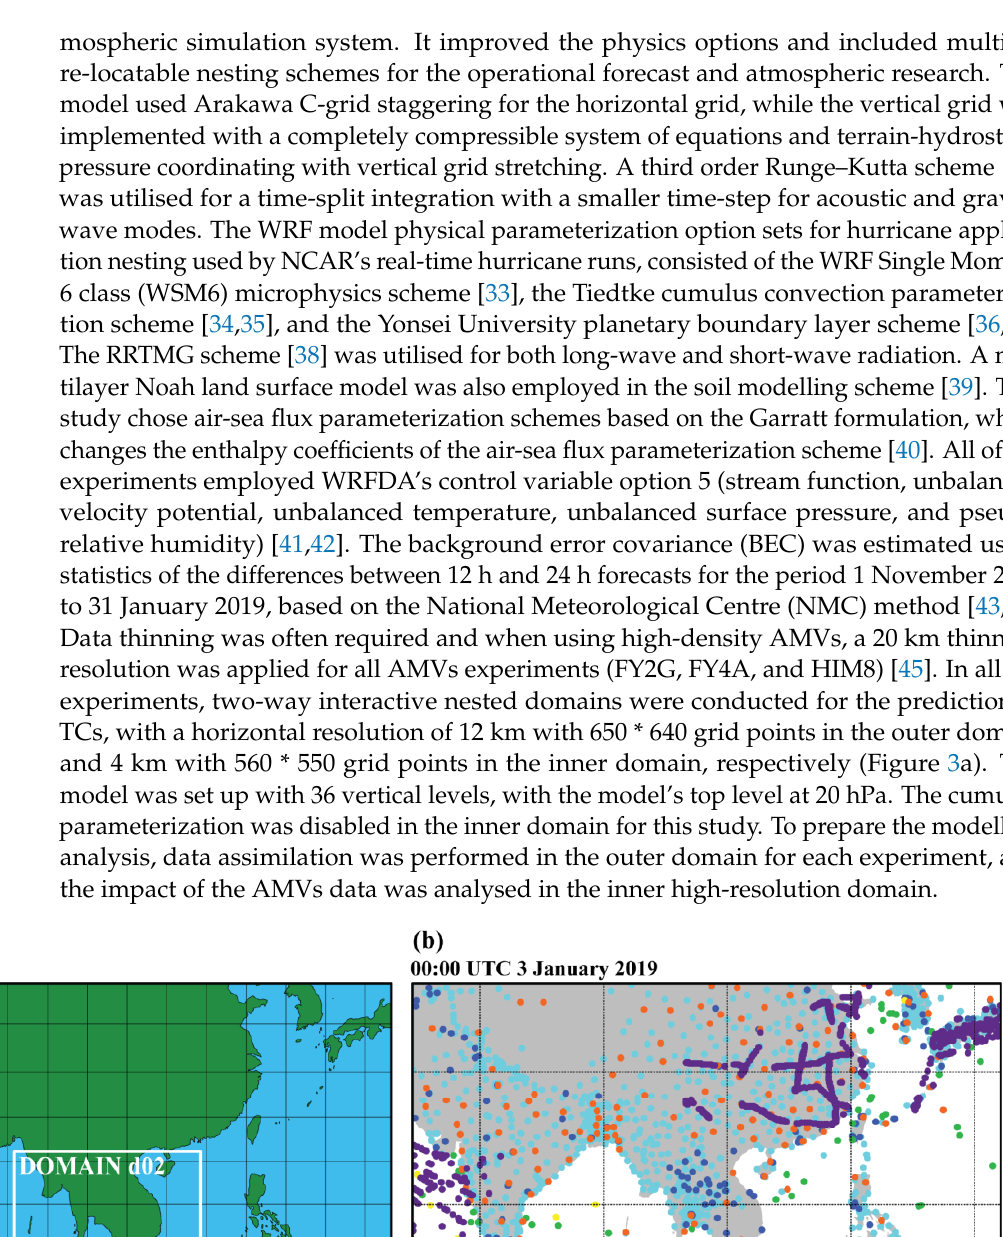
Figure 4. Flow charts of the 6 partially-cycling experiments, every 12 h updated, starting from 00:00 UTC 1 January 2019 to 12:00 UTC 3 January 2019, respectively.